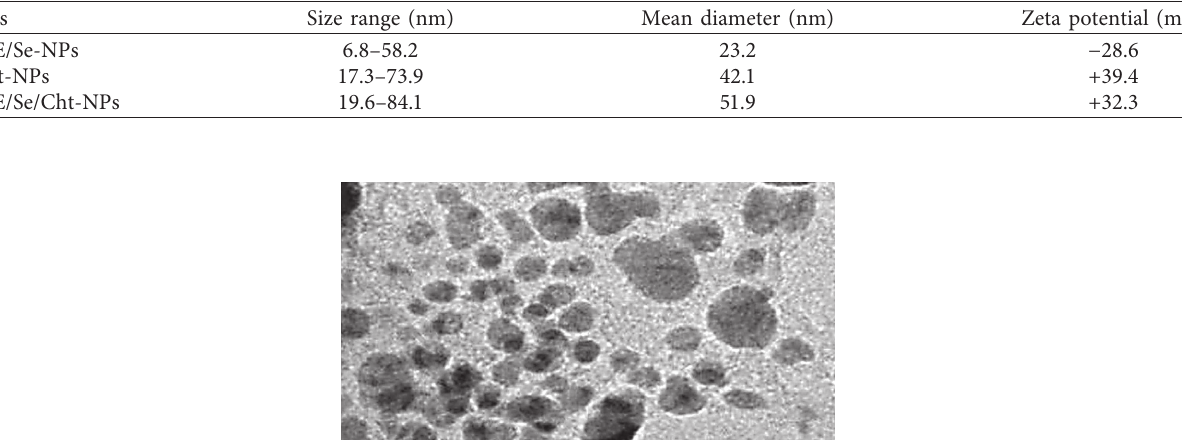
Table 1: The Ps distribution and their zeta potential for synthesized Cht-NPs, CIE/Se-NPs, and CIE/Se/Cht-NPs.